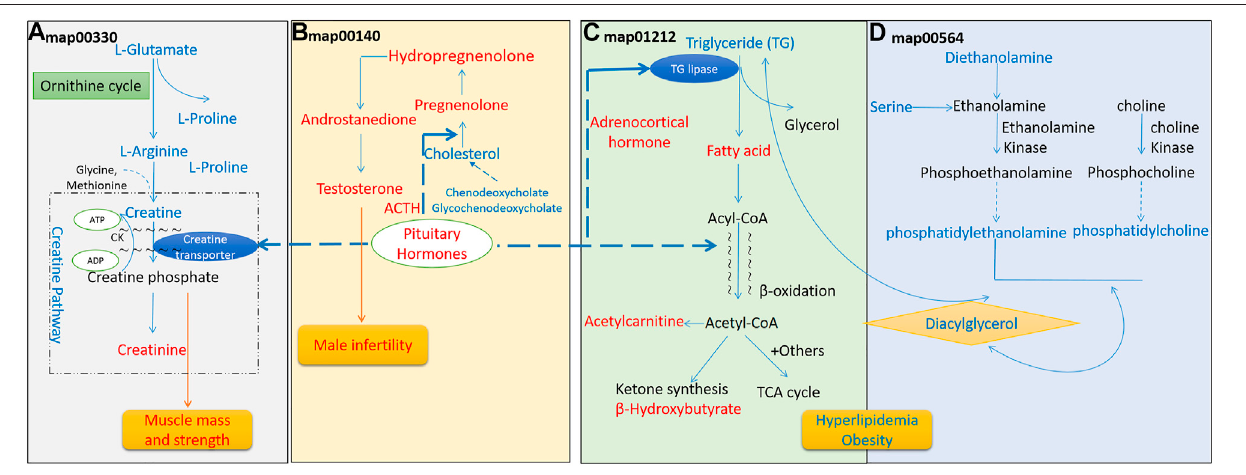
FIGURE 7 | Perturbed metabolism signaling pathways in hypopituitarism. (A) . Perturbed arginine and proline metabolism; (B) . Perturbed steroid hormone synthesis; (C) . Perturbed fatty acid metabolism; (D) . Perturbed glycerophospholipid synthesis. Metabolites in blue increased in the serum, and metabolites in red decreased.